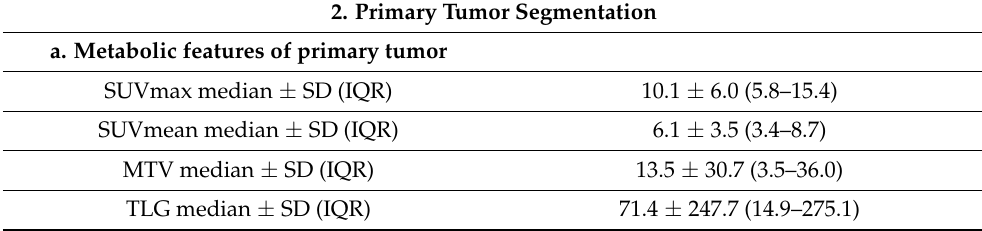
Table 2. Metabolic and morphological features of all segmented NSCLC (N = 125) before initiating